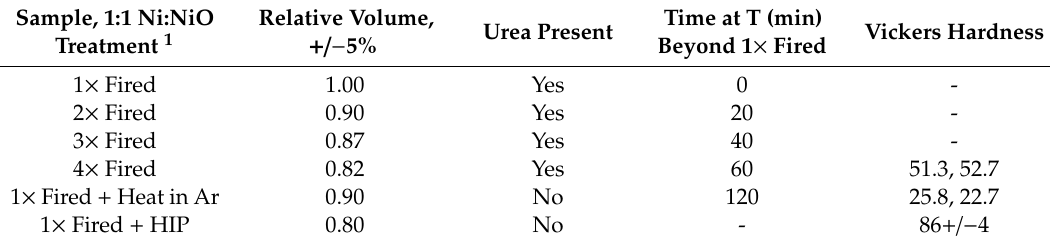
Table 2. Accelerated Sintering: density and hardness of samples after various treatment regimes.